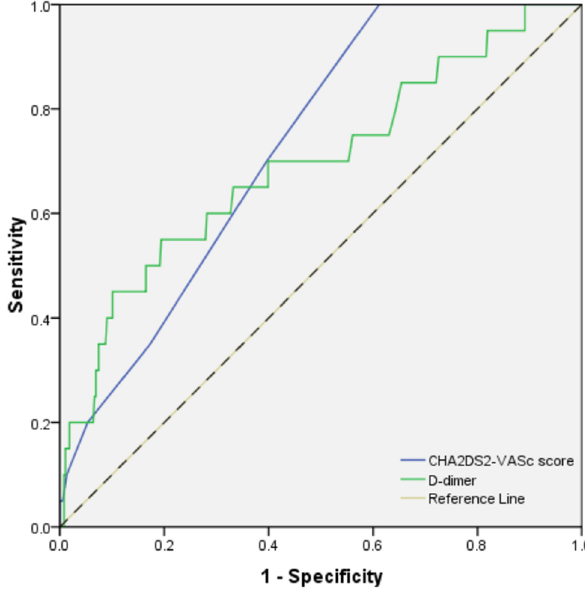
Figure 2: ROC analysis of CHA 2 DS 2 - VASc score and D - dimer in predicting LAAT. LAAT = left atrial appendage